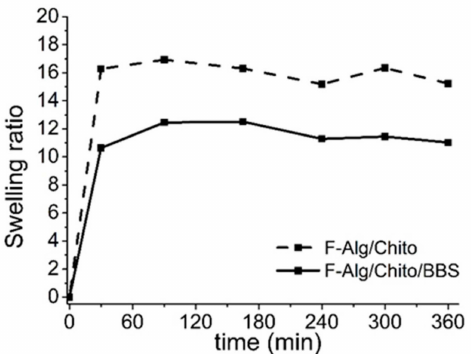
Figure 4. Time dependence of swelling ratios for dried films: F-Alg / Chito / BBS (solid line) and F-Alg / Chito (dashed line).